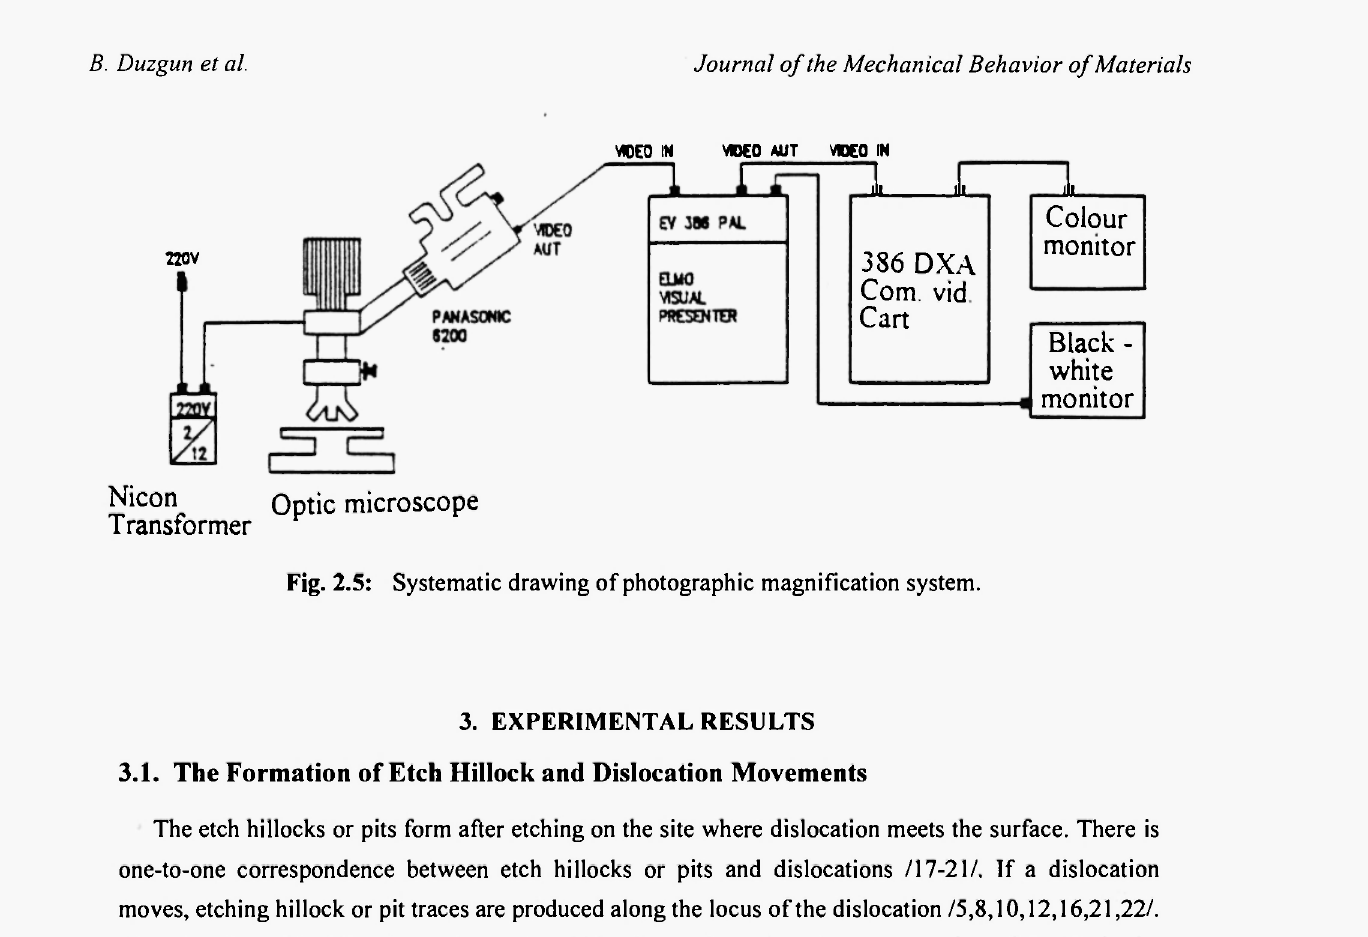
Fig. 2.5: Systematic drawing of photographic magnification system.